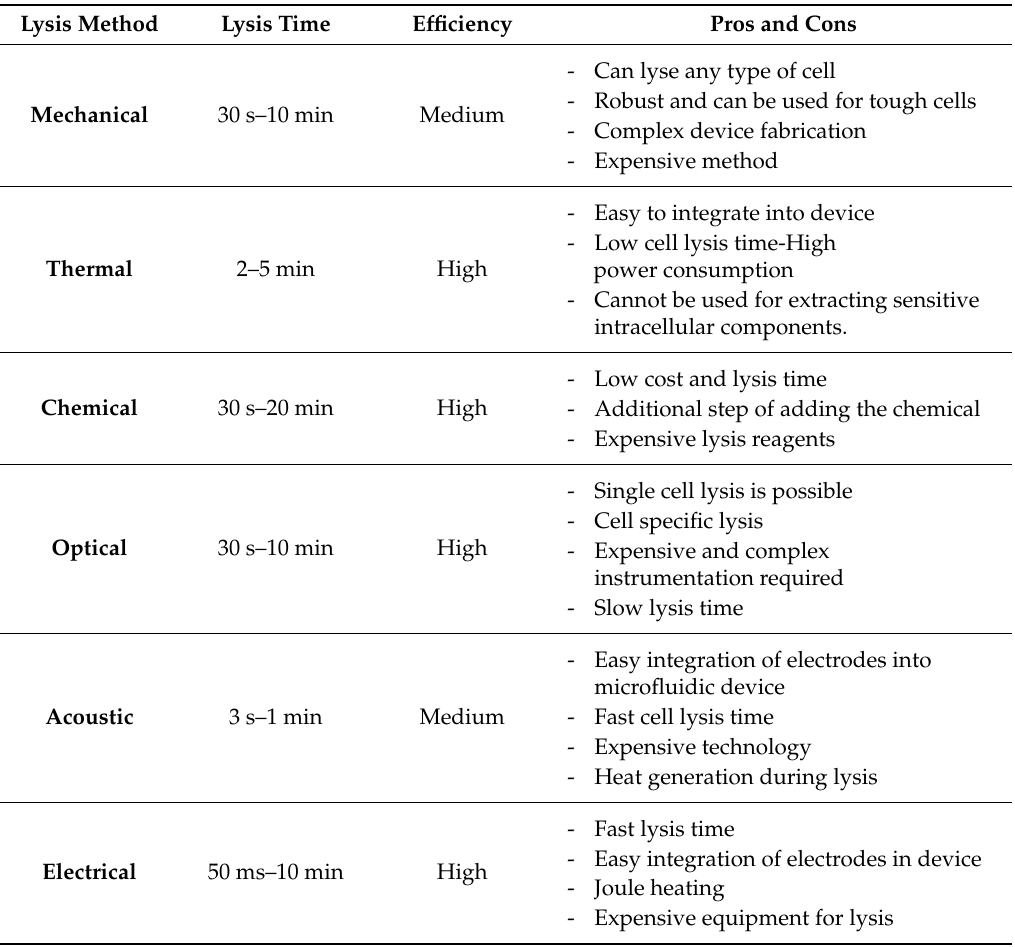
Table 5. Comparison of different microfluidic lysis methods. Cell lysis efficiency was determined by averaging the lysis efficiencies from the references cited. Low: 0%–50%; Medium: 50%–80%; High: